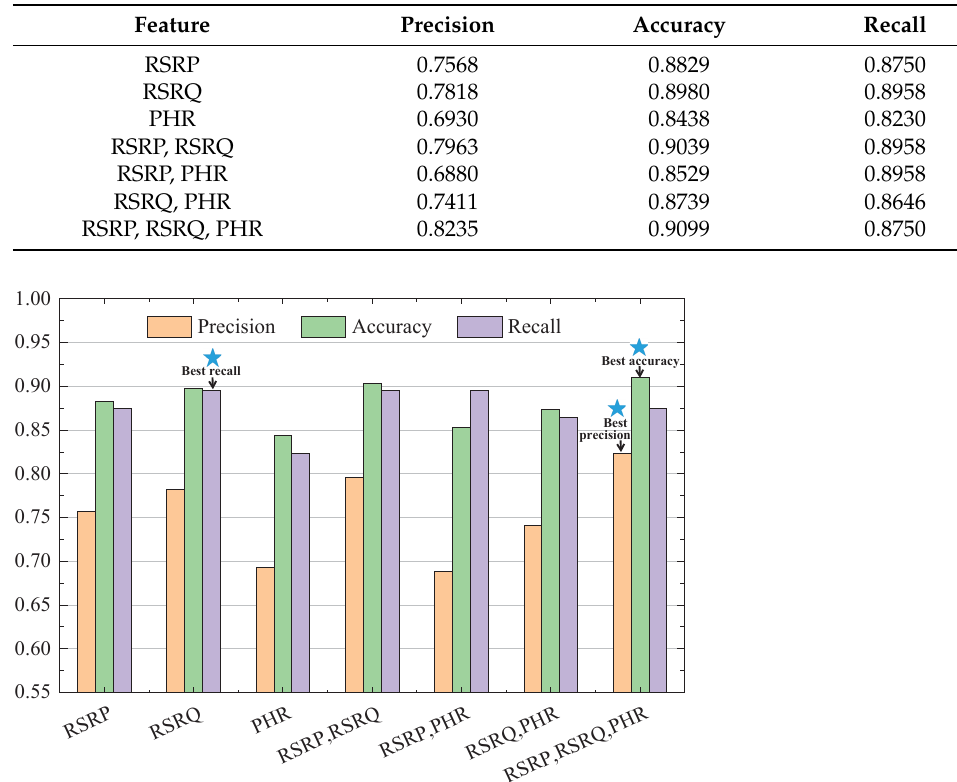
Figure 8. Performance comparison between feature combinations when the number of clusters is